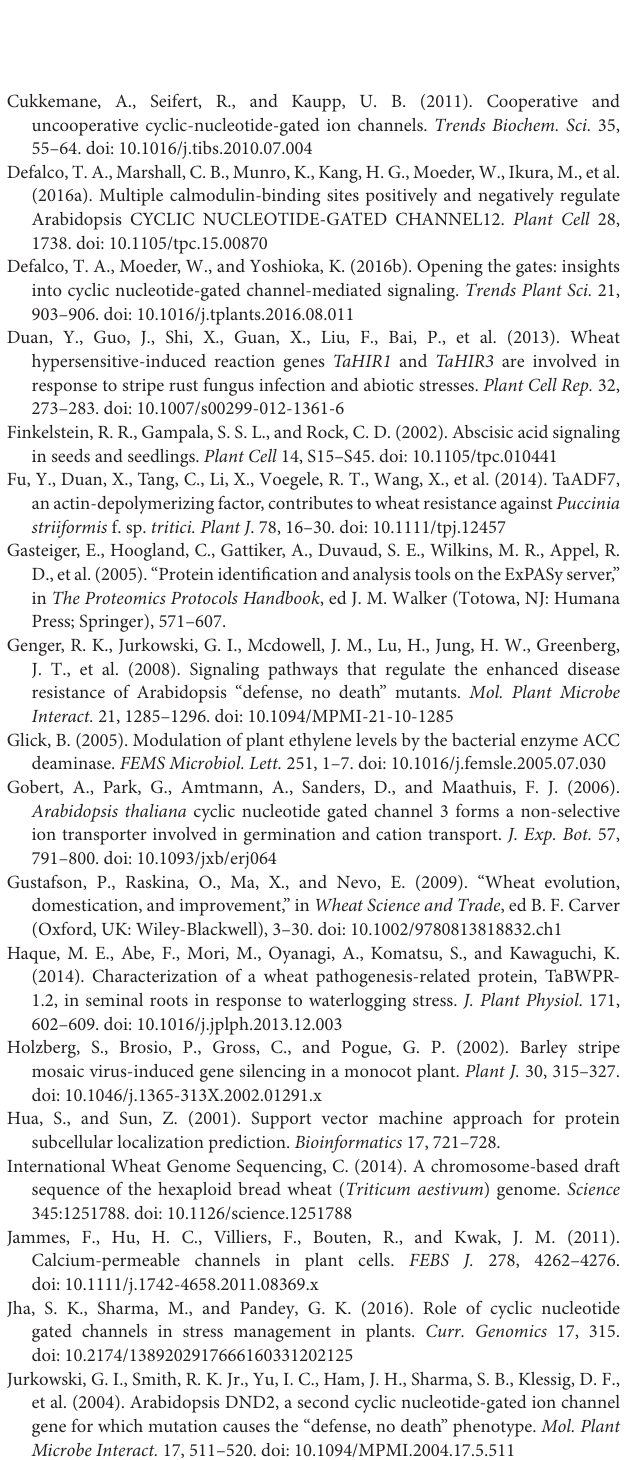
Table S1 | Gene ID and location of the TaCNGCs . Table S2 | TaCNGCs sequence analysis. Table S3 | cis-acting element of TaCNGCs .